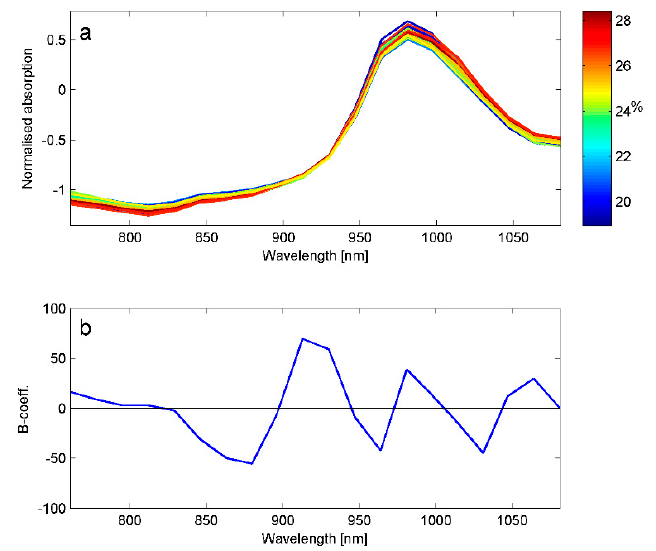
Figure 4. ( a ) SNV-corrected spectra from Innovator potatoes colored according to dry matter content. ( b ) Regression coefficients for the calibration model for dry matter in potatoes.